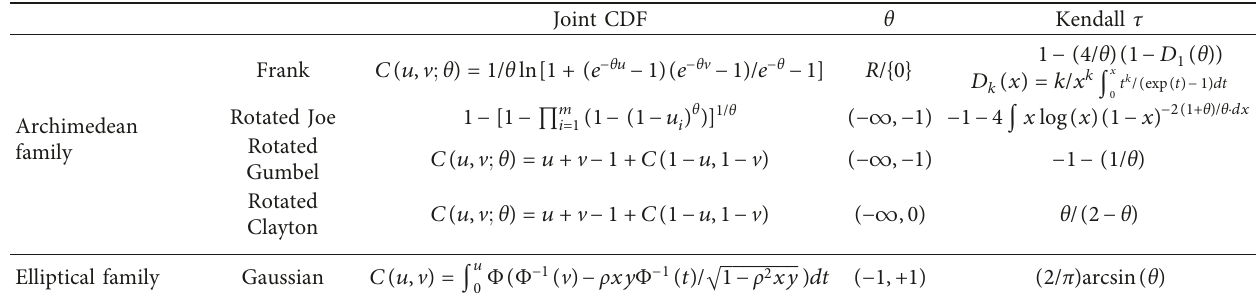
Table 3: Different types of copula